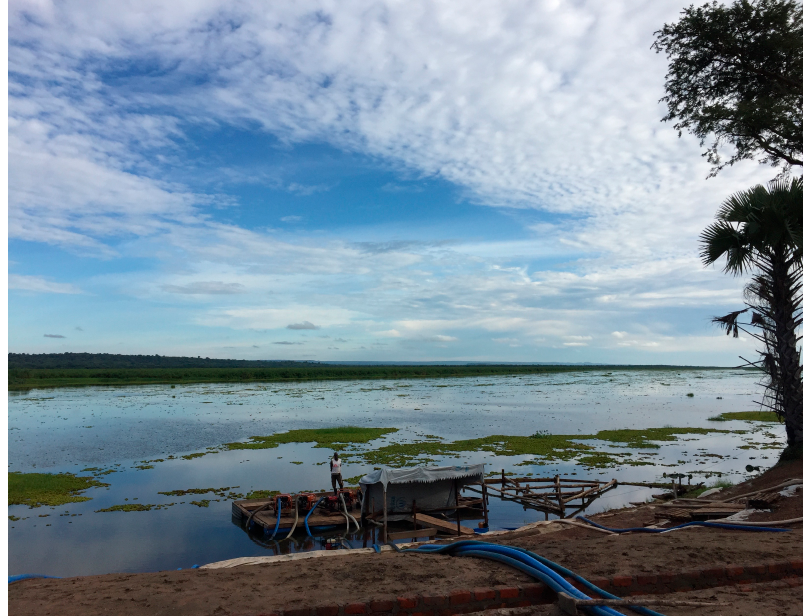
Figure 3. Raw water intake from the White Nile at the Palorinya SWTP in August 2017; note marshy condition of river (Source: Syed Imran Ali).